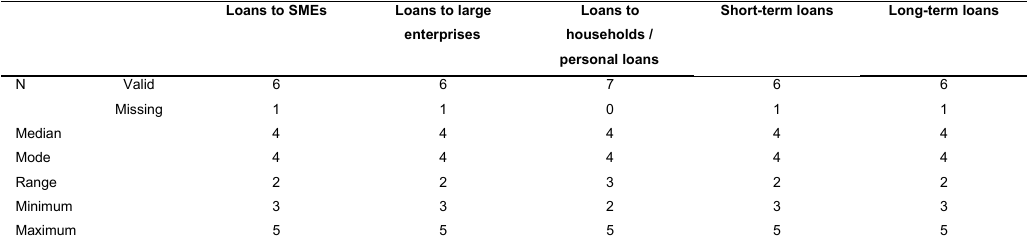
Table 7. The impact of renewed regulation on the price of credit in different lending scenarios. Loans to SMEs Loans to large Loans to enterprises households /